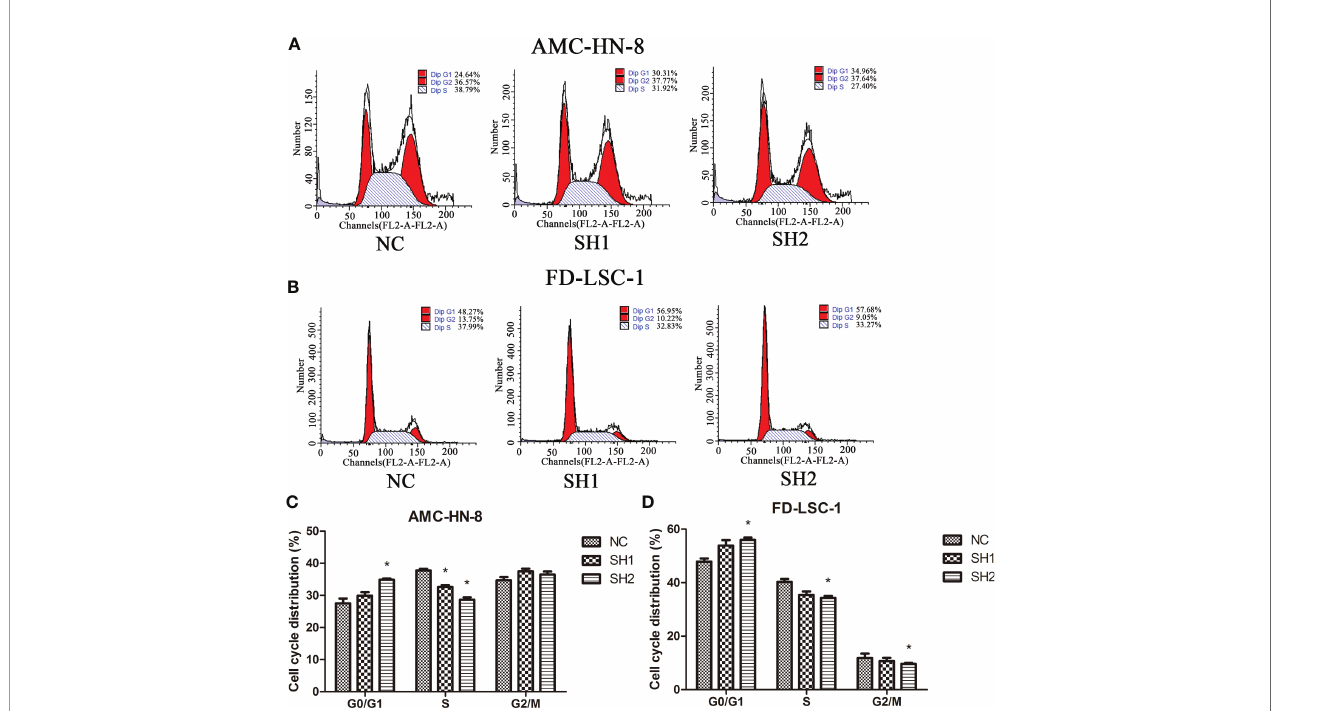
FIGURE 3 | Cell cycle distribution of DIAPH1 knockdown (SH) and the negative control (NC) as detected by fl ow cytometric analysis. (A, B) Representative graphs of cell cycle distribution in AMC-HN-8 and FD-LSC-1 cells by fl ow cytometric analysis. (C, D) Comparison of the proportional distribution of cell cycle between three groups. ∗ p < 0